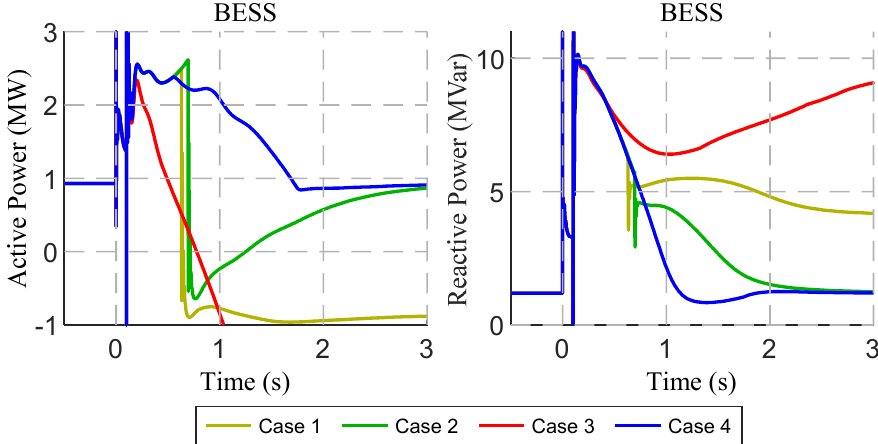
Figure 29. BESS power converter active and reactive power outputs.